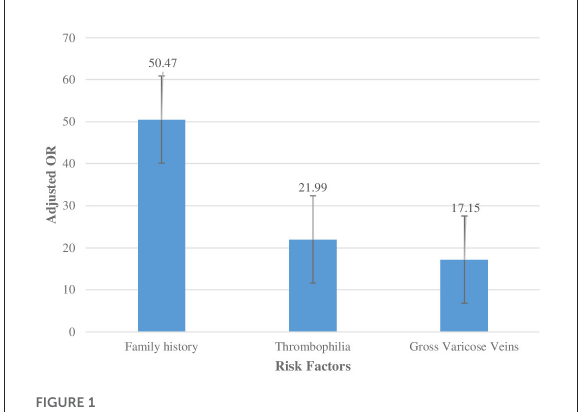
FIGURE1 Adjusted ORs for each significant factor of VTE in the multiple logistic regression